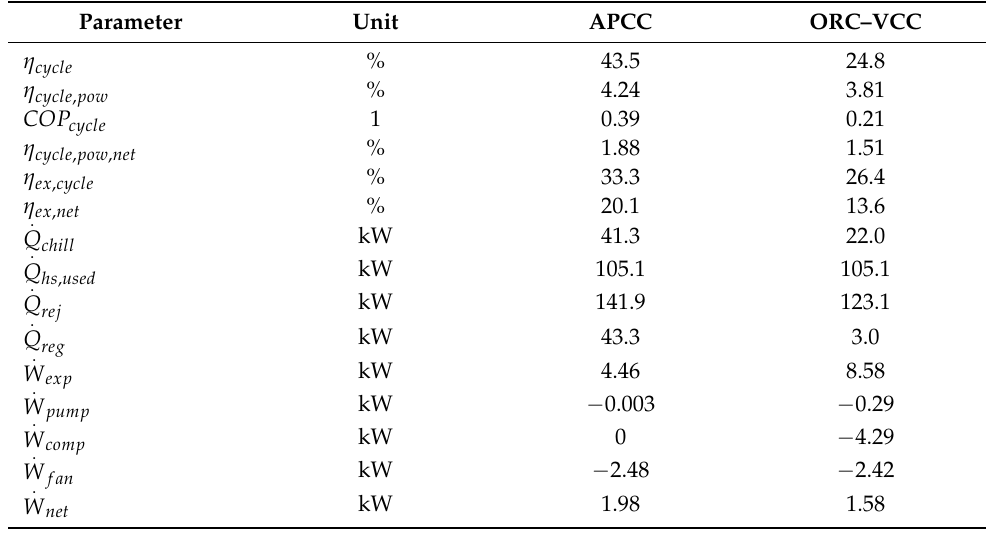
Table 2. Main resulting parameters of the APCC and ORC–VCC at baseline conditions with SR 0.5.